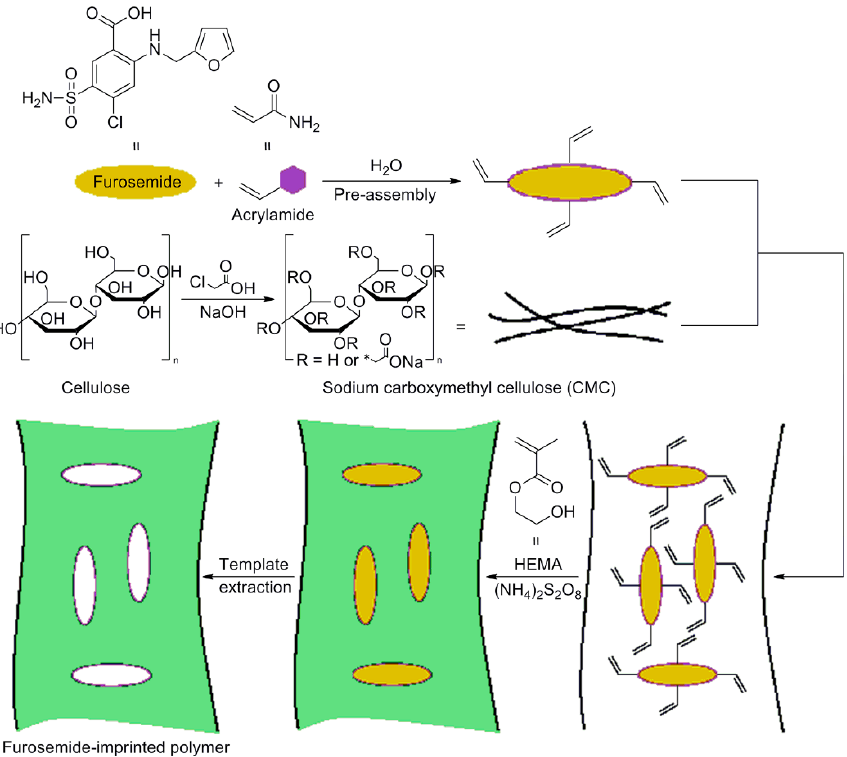
Figure 6. Synthesis procedure of cellulose-based MIP specific for Furosemide drug. Reproduced from the work in [70] with permission from Wiley.